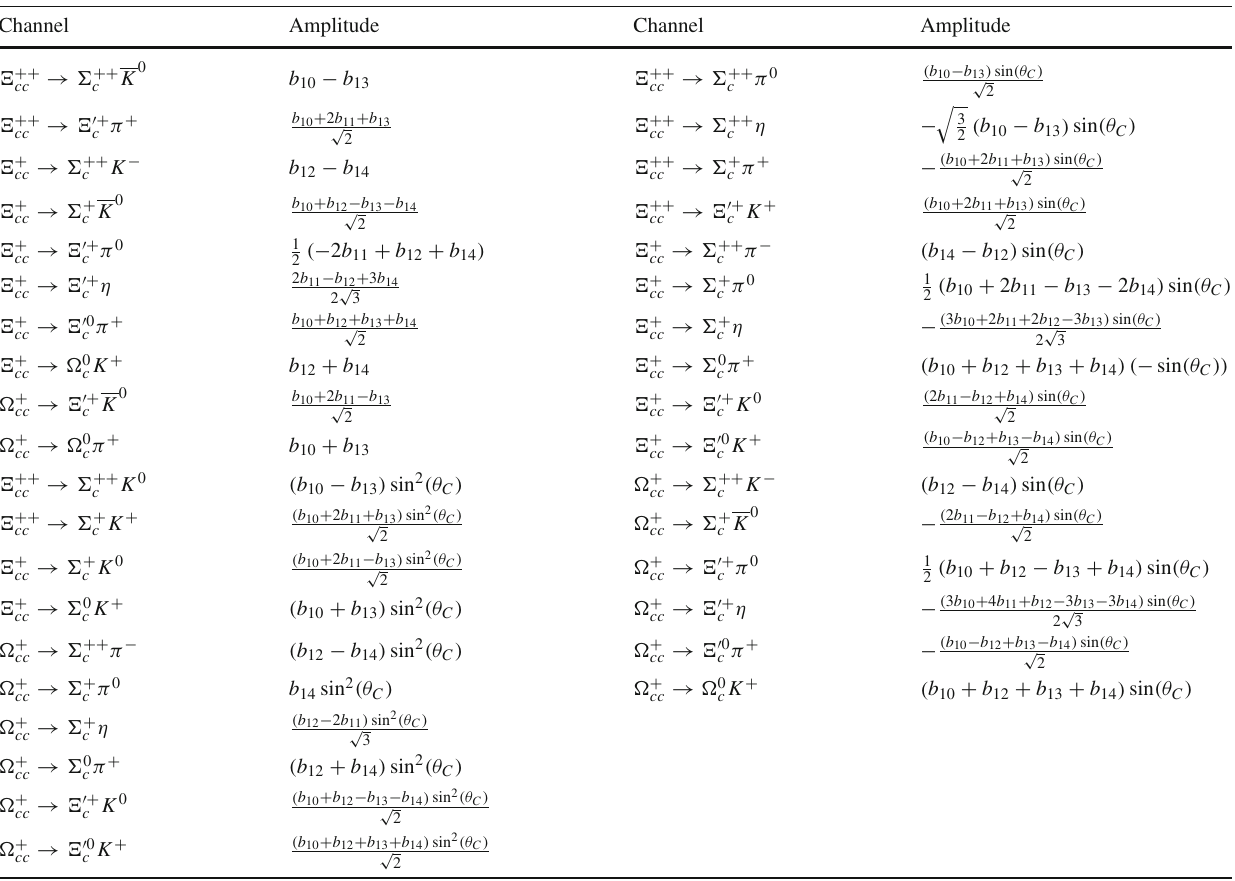
Table 6 Doubly charmed baryons decays into a cqq (sextet) and a light meson Channel Amplitude